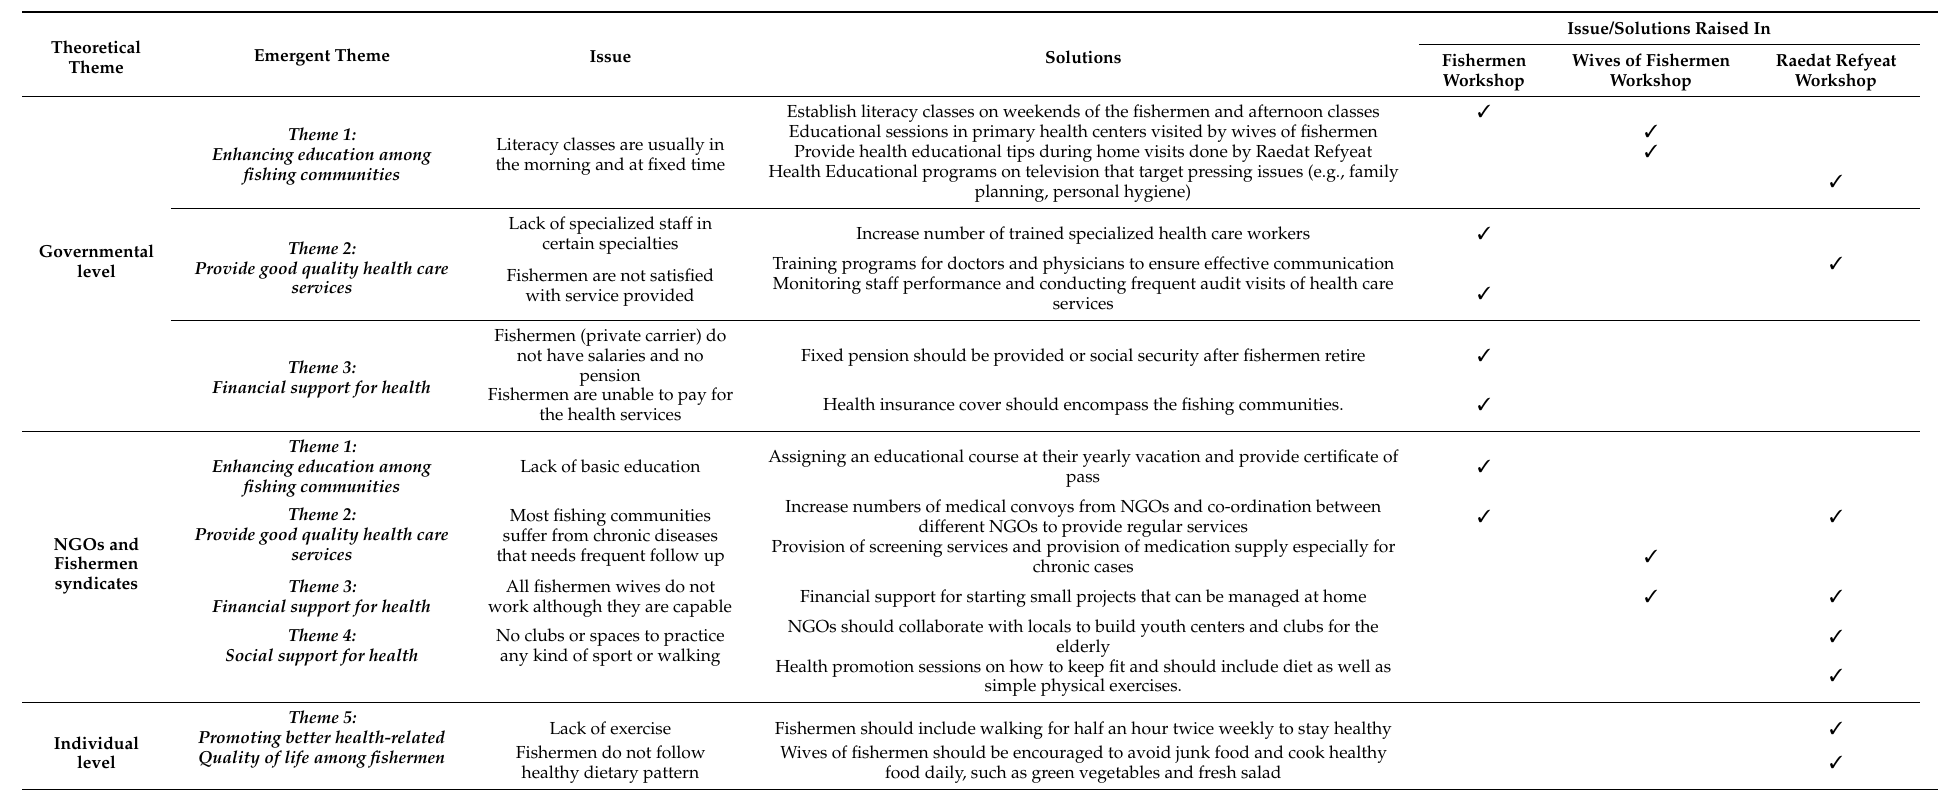
Table 5. Workshop thematic